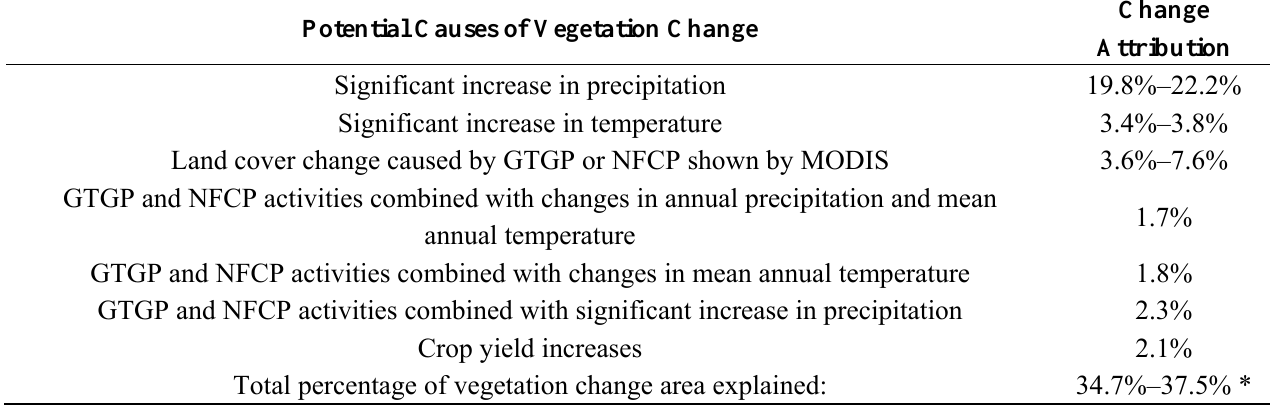
Table 6. Change attribution